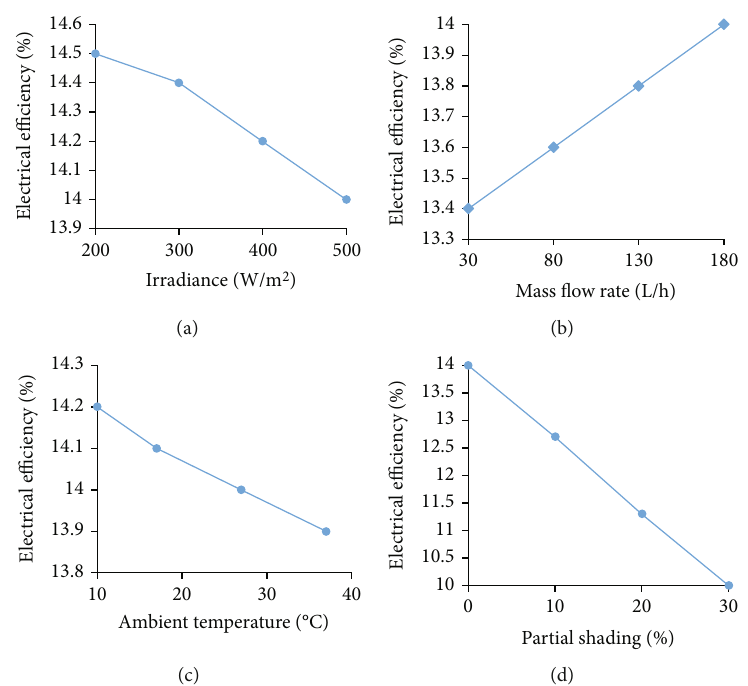
Figure 14: Outcome of (a) G , (b) V